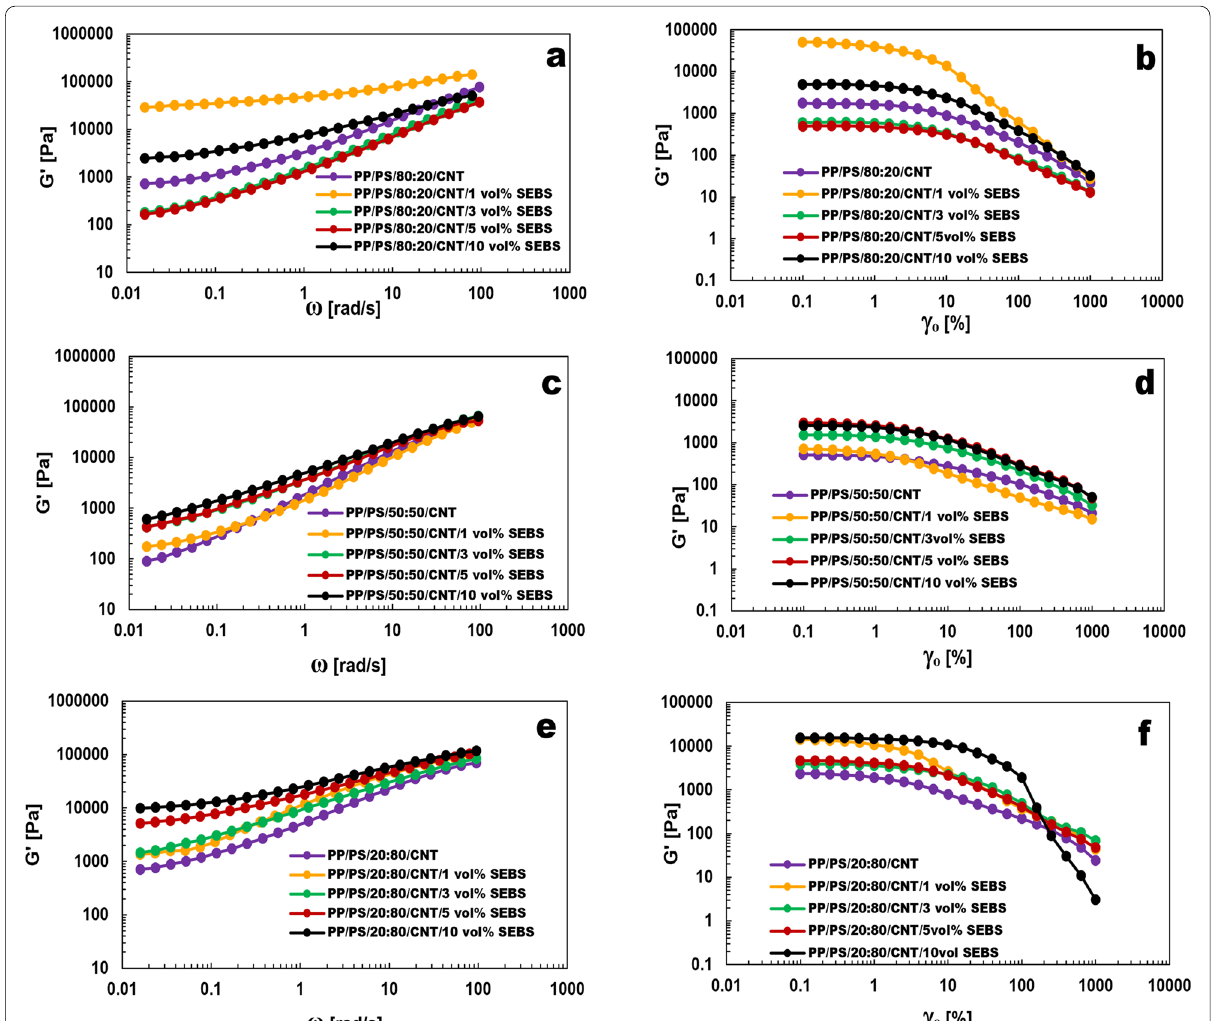
Fig. 5 Frequency and strain sweep of PP/PS/MWCNT/SEBS triblock at different concentration a-b ) 80:20, c-d ) 50:50, and e-f ) 20:80 blend